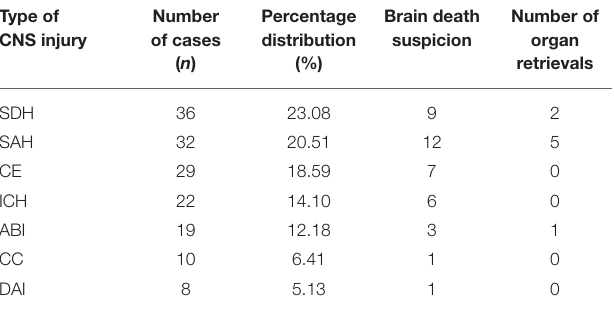
TABLE 3 | Types of cerebral injury in the analyzed DBD